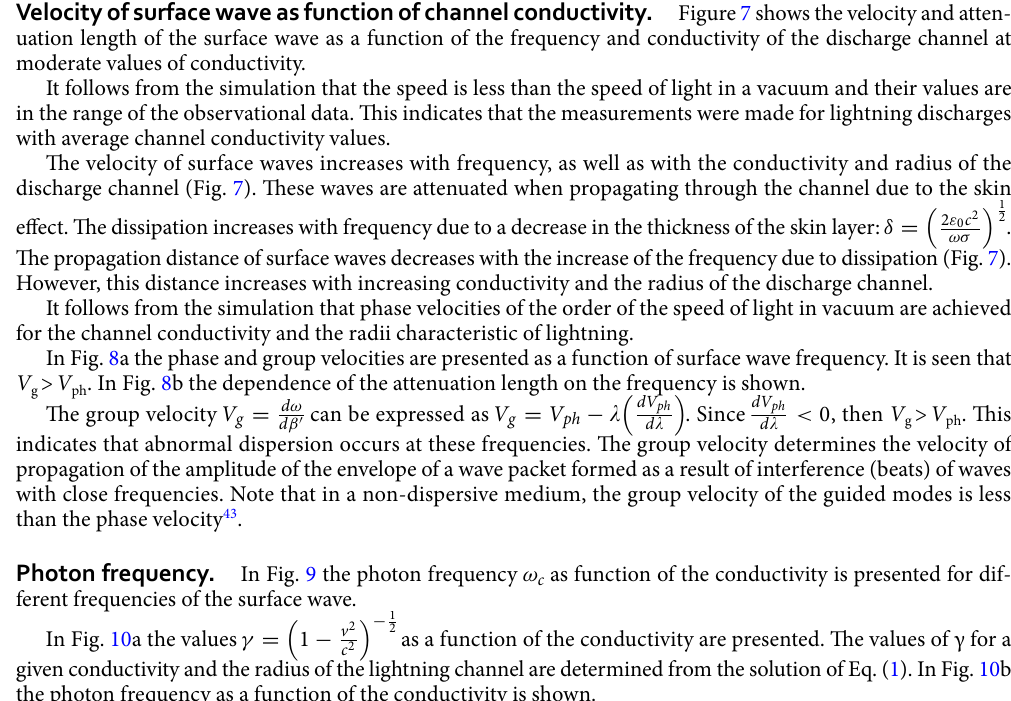
Velocity of surface wave as function of channel conductivity.